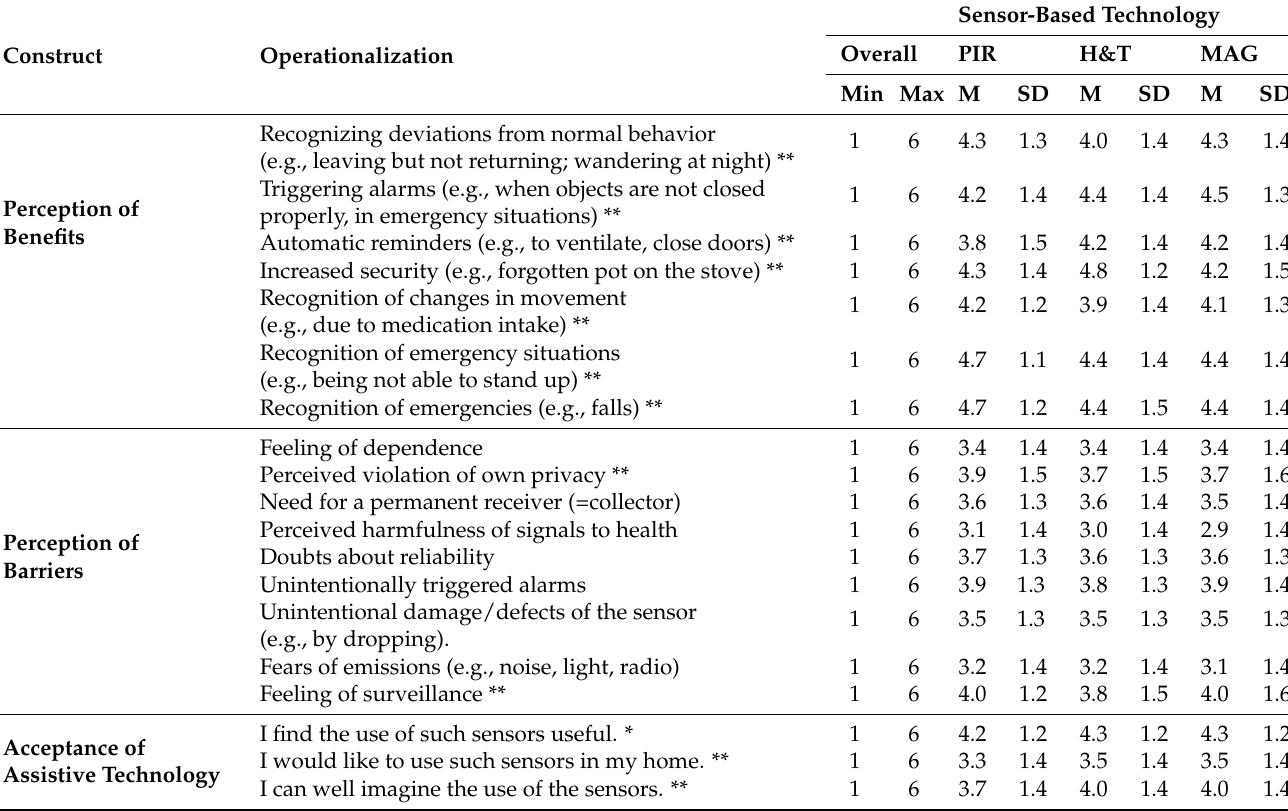
Table 1. Descriptive statistics of the participants‘ evaluation of the three sensor-based lifelogging technologies.